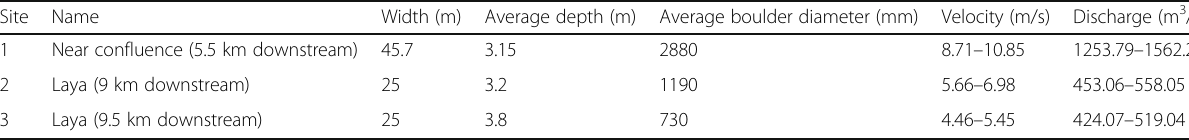
Tsho (Fig. 1) (https://earthquake.usgs.gov/archive/prod- uct/losspager/us10002m67/us/1441220705024/onepa- ger.pdf). The earthquake with hypocenter at depth of 27 km struck at 7:10 am BST on 28 June 2015. Tremor